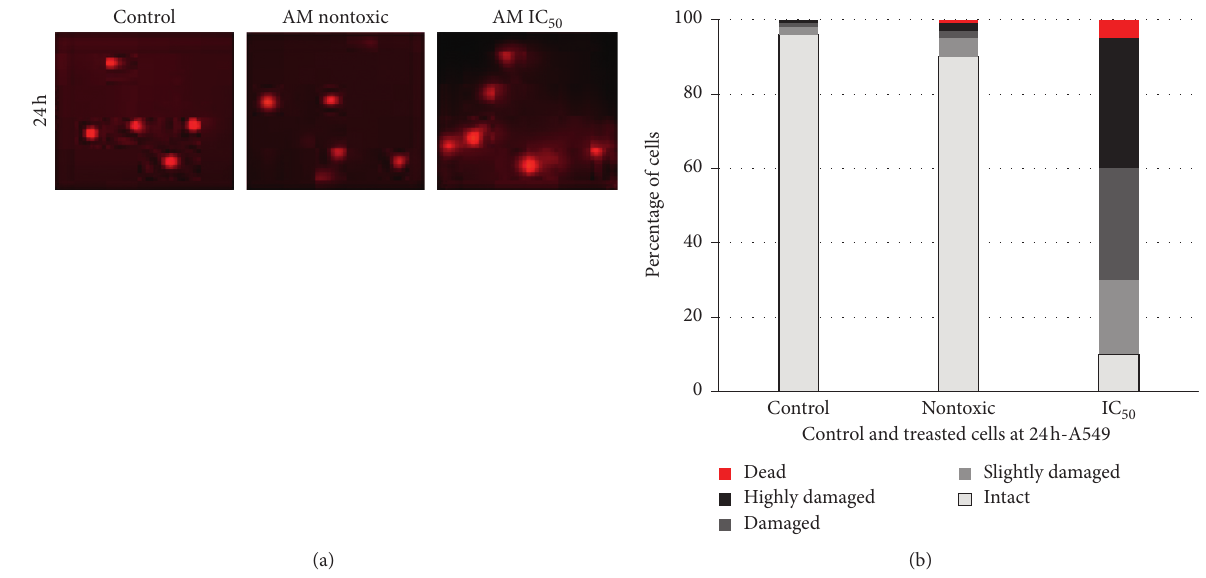
Figure 4: Assessment of DNA damage in A549 cells adopting comet assay. Data for the other cells are not shown since all showed similar trend. (a) DNA damage induced by A. malaccensis extract. Treated cells in which DNA has undergone strand breaks look like comets. (b) DNA damage as defined according to the DNA in the tail. The multiple parts of each column (from the bottom to the top): intact (0–20%), slightly damaged (20–40%), damaged (40–60%), highly damaged (60–80%), and dead (80–100%). Data are expressed as average of three independent experiments. Table 1: Organ weights (g) of female rats.